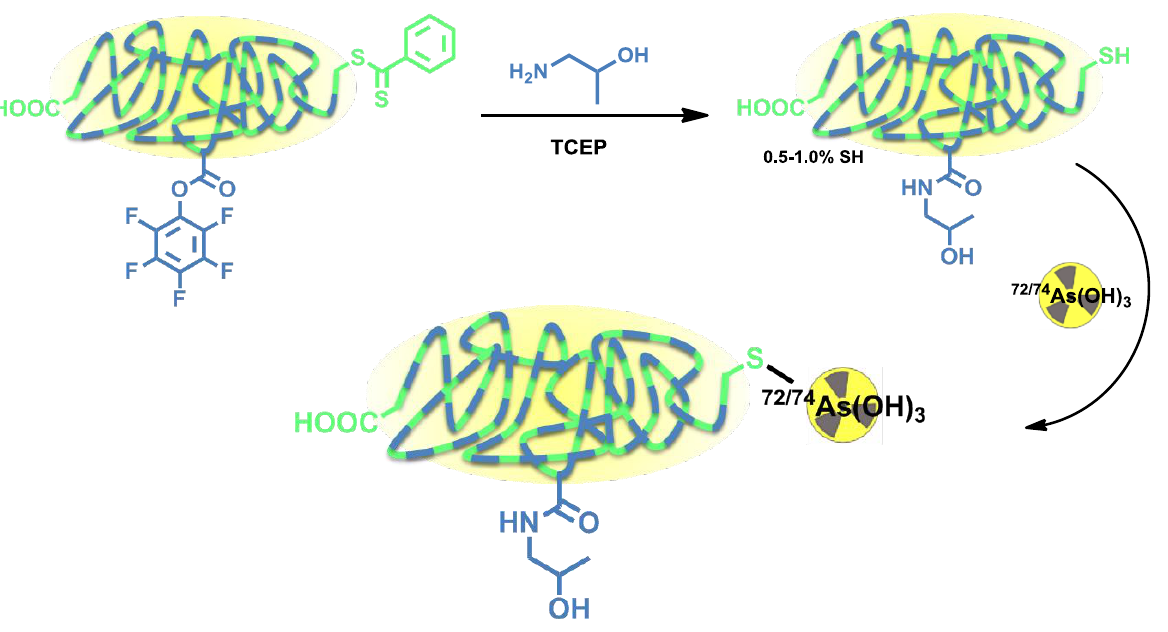
Figure 7. Thiol-functionalization of HPMA-based polymers and radiolabeling strategy for 72/74 As-labeled HPMA-based